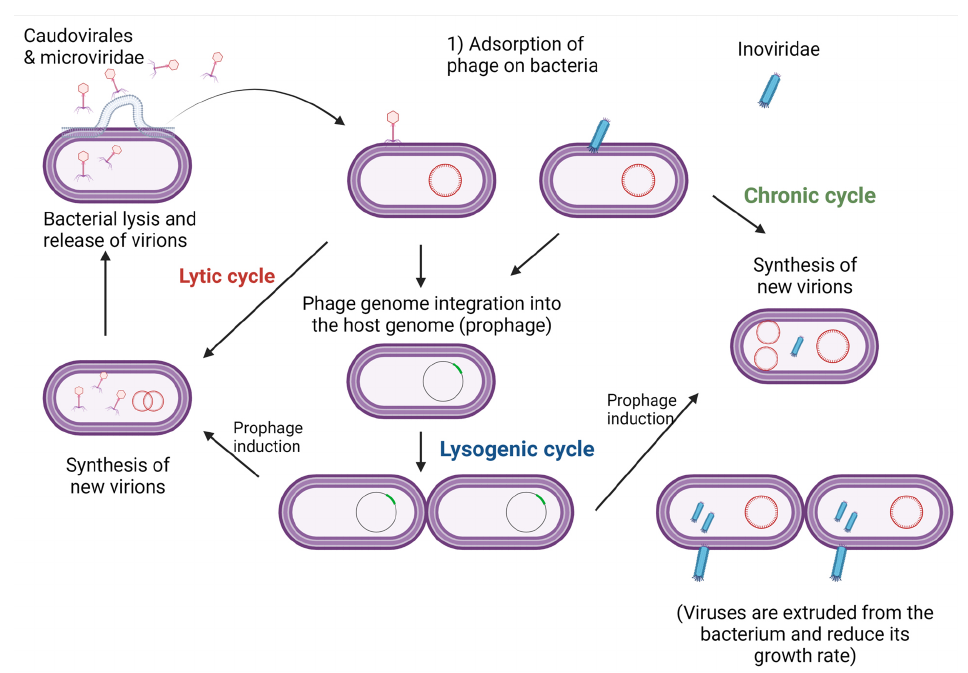
Figure 1B. Life cycles of phages. Bacteriophages can either be lytic, in which case they cause lysis of the bacterial cell and release progeny within a short period of time, or lysogenic, in which case they inject their genome into the bacterial genome and stay dormant for a while until they get activated and release progeny. For therapeutic purposes, the preferred type of phage is lytic, as killing of the bacteria within a short period of time is necessary in treatment of bacterial